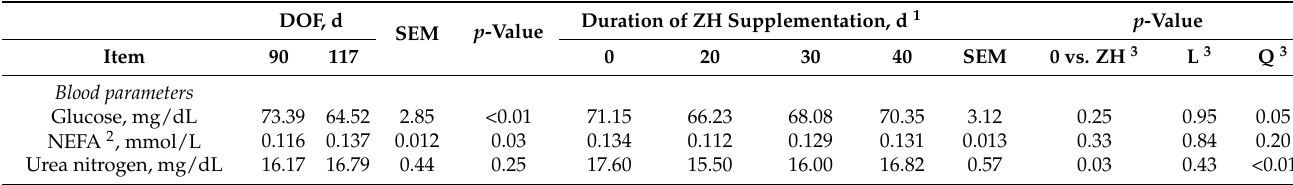
(15.50 and 16.00 mg/dL, respectively) and the highest values obtained for the control group Blood NEFA was higher in bulls fed for 117d compared to those fed for 90 d in the feed- NEFA, with the highest values of blood NEFA observed post zilpaterol supplementation (0.117 vs. 0.137 mmol/L; p = 0.03). However, blood NEFA and glucose were not affected by ZH. Table 4. Least square means, standard error of the mean (SEM) and probabilities of blood parameters, according to the duration of zilpaterol hydrochloride (ZH) supplementation and days on feed (DOF). DOF, d Duration of ZH Supplementation, d 1 p -Value SEM p -Value Item Blood parameters Glucose,